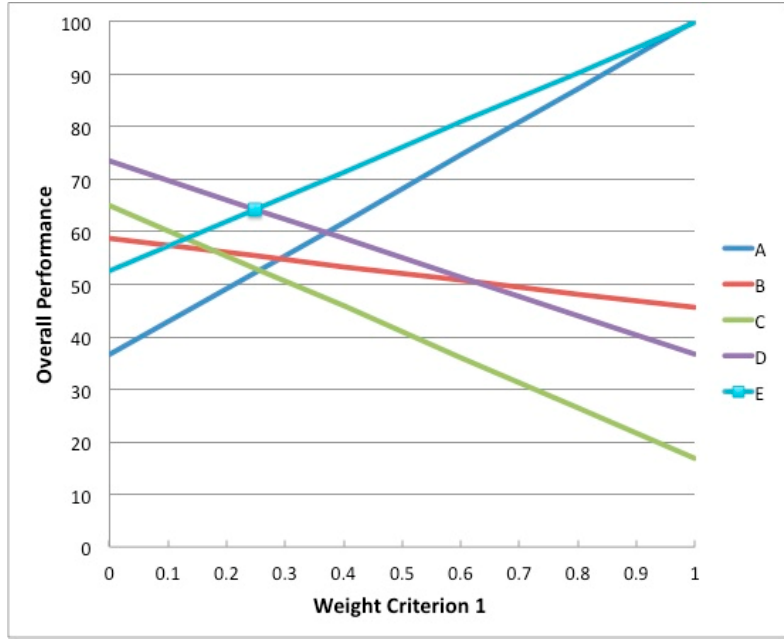
Figure 10. Sensitivity analysis targeting the weight of C1.